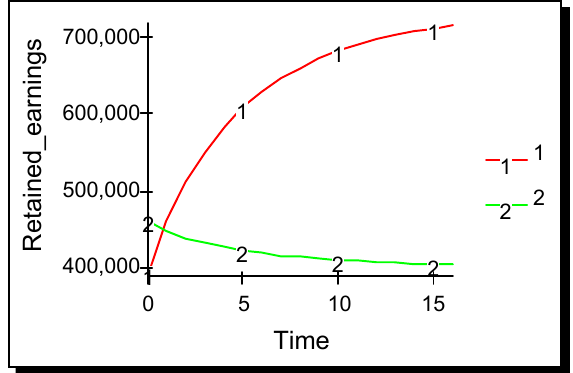
Figure 3. Unilateral advertising, below threshold. Advertising effectiveness: φ 1 = 0.000010; φ 2 = 0.